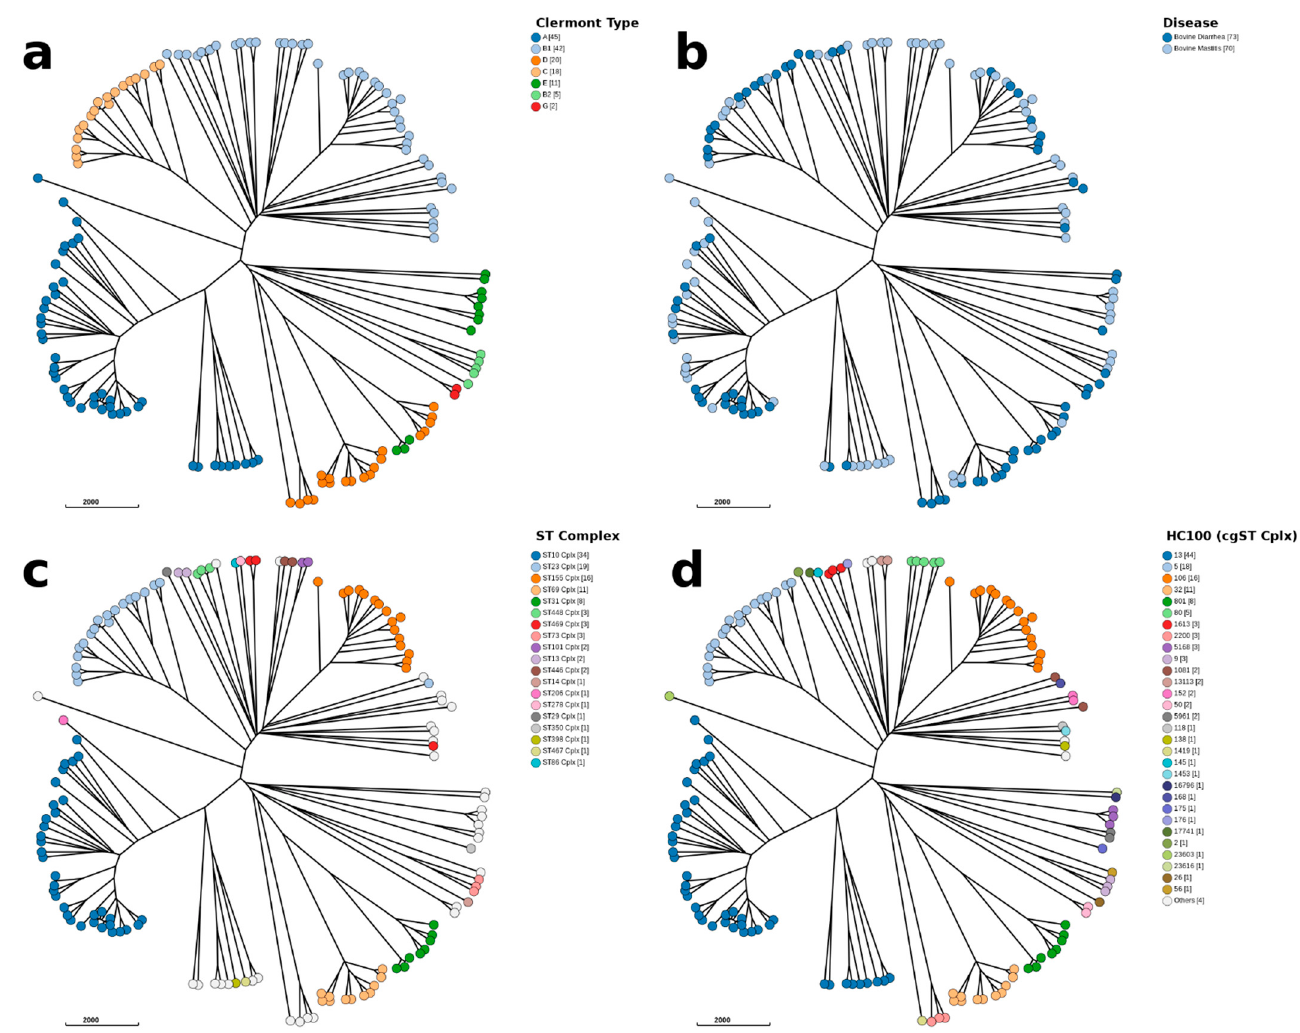
Figure 1. wgMLST Ninja Neighbour Joining GrapeTree. ( a ) Isolates coloured in based on the Clermont Type phylogrouping scheme. ( b ) Isolates from bovine mastitis or diarrhoea samples were broadly distributed in the phylogenetic tree. ( c ) The ST complexes were also well represented in the collection of isolates. ( d ) Separation of isolates by hierarchical clustering (HC1100) corresponds with the ST complexes as previously noted.